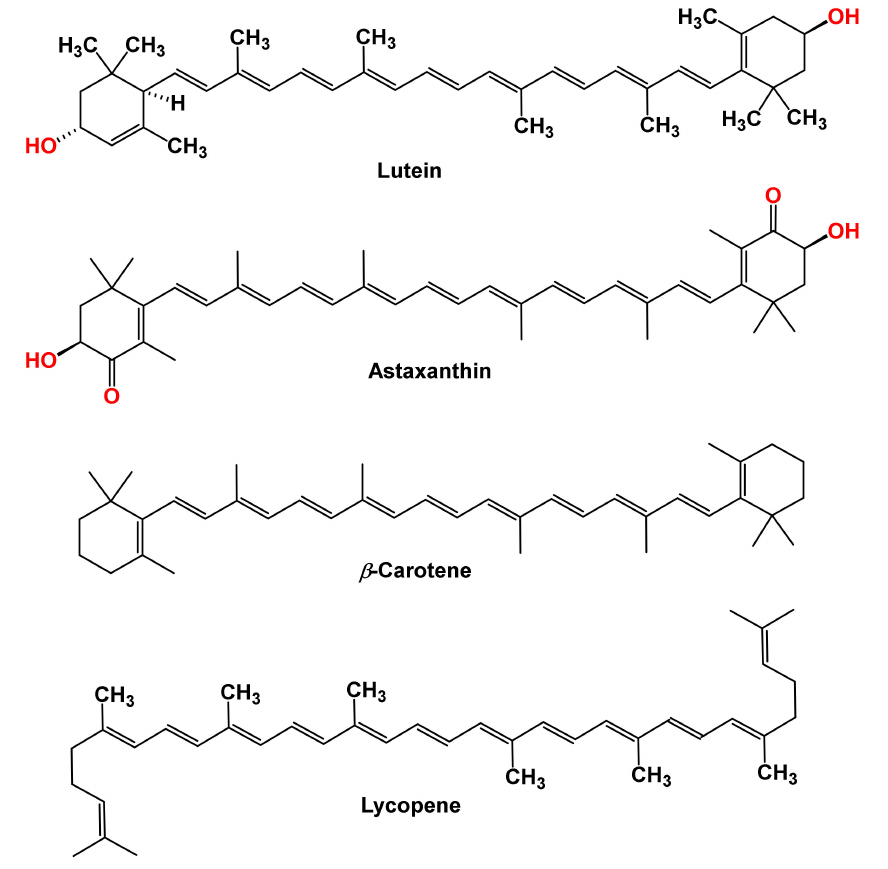
Figure 1. Structures of common